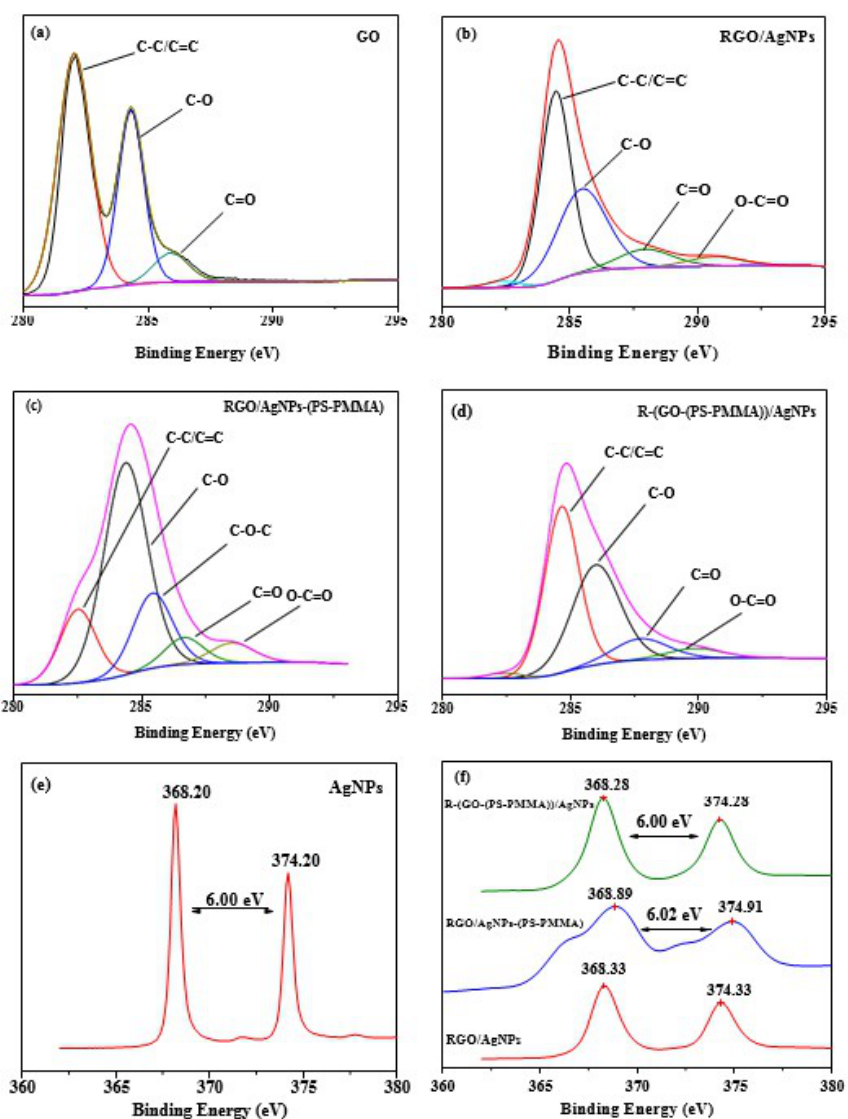
Figure 3. C1s and Ag3d XPS spectra of ( a ) GO, ( b ) RGO-AgNPs, ( c ) RGO-AgNPs-(PS-PMMA), ( d ) R-(GO-(PS-PMMA)-AgNPs, ( e ) AgNPs, and ( f ) the nanocomposites.